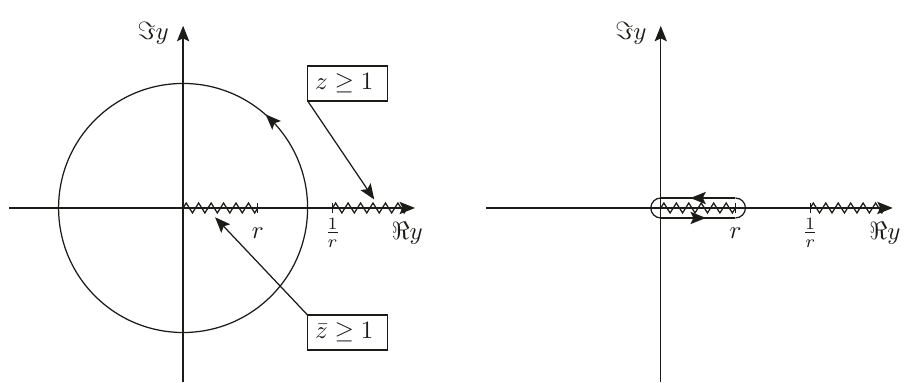
Figure 6 . Position of the branch cuts in z and (cid:22) z in the complex y -plane for r < 1 (left). The contour along the unit circle in eq. (5.9) can be deformed and, consequently, identi(cid:12)ed with the integral of the (cid:22) z -discontinuity (right), as written in eq.